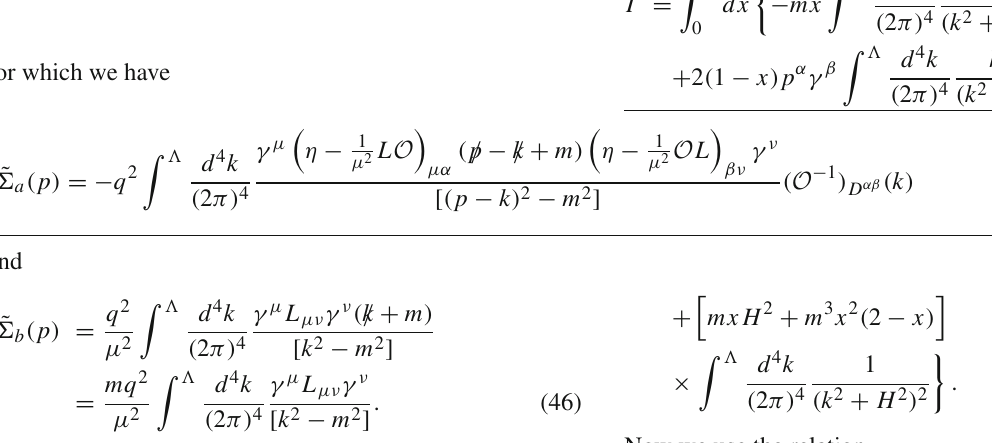
Fig. 4 Contributions to the one-loop self-energy of the fermion in the dual